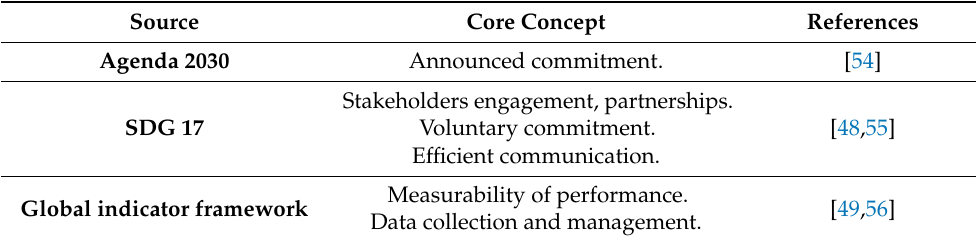
Table 1. Concepts from the UN Agenda 2030 and SDG